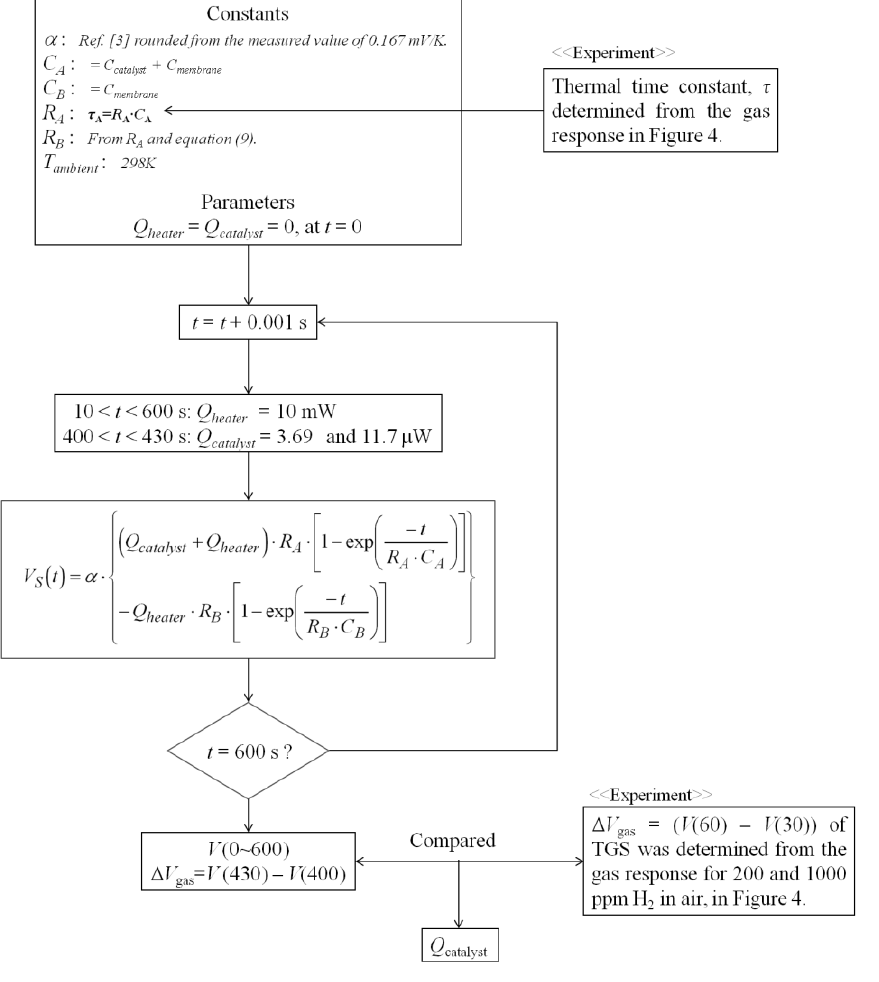
Figure 5. Flow chart for the simulation for calculating the voltage signal V Equation (15) of TGS compared to the experimental response Δ V